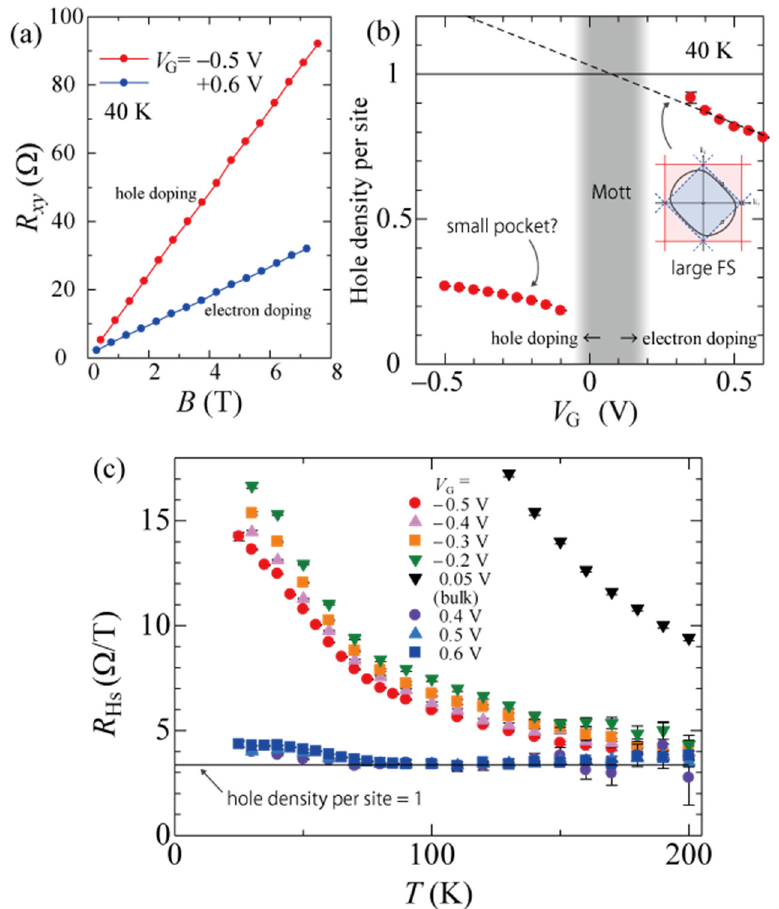
Figure 10. ( a ) Hall resistance vs. magnetic field at 40 K. ( b ) Gate-voltage dependence of the hole density per site (estimated from 1/ eR H ) at 40 K. The dashed line denotes the hole density per site estimated from the volume bounded by the noninteracting FS assuming that doping concentration is proportional to V G (20% doping at 0.5 V). The center of the shaded insulating region corresponds to the charge neutrality point (resistivity peak). ( c ) Temperature dependence of R Hs . The solid line indicates the value where the hole density per site becomes one (half filling).